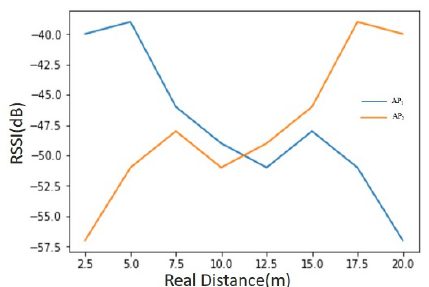
Figure 11. RSSI distributions of AP 1 and AP 2